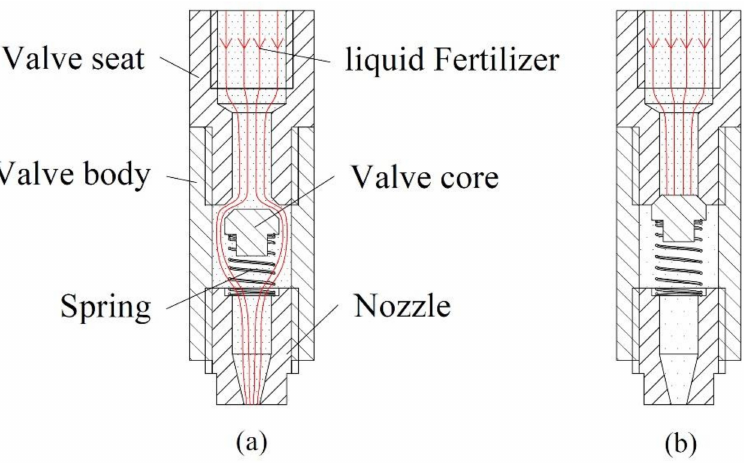
Figure 3. Working principle of spray nozzle, ( a ) opening and ( b ) closing of spray